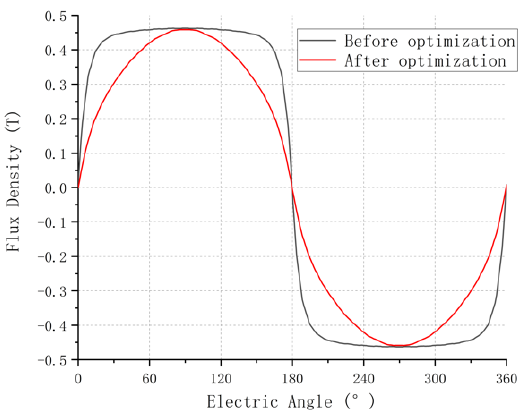
Figure 7. Comparison of air-gap magnetic field waveform at 50 mm eccentricity.